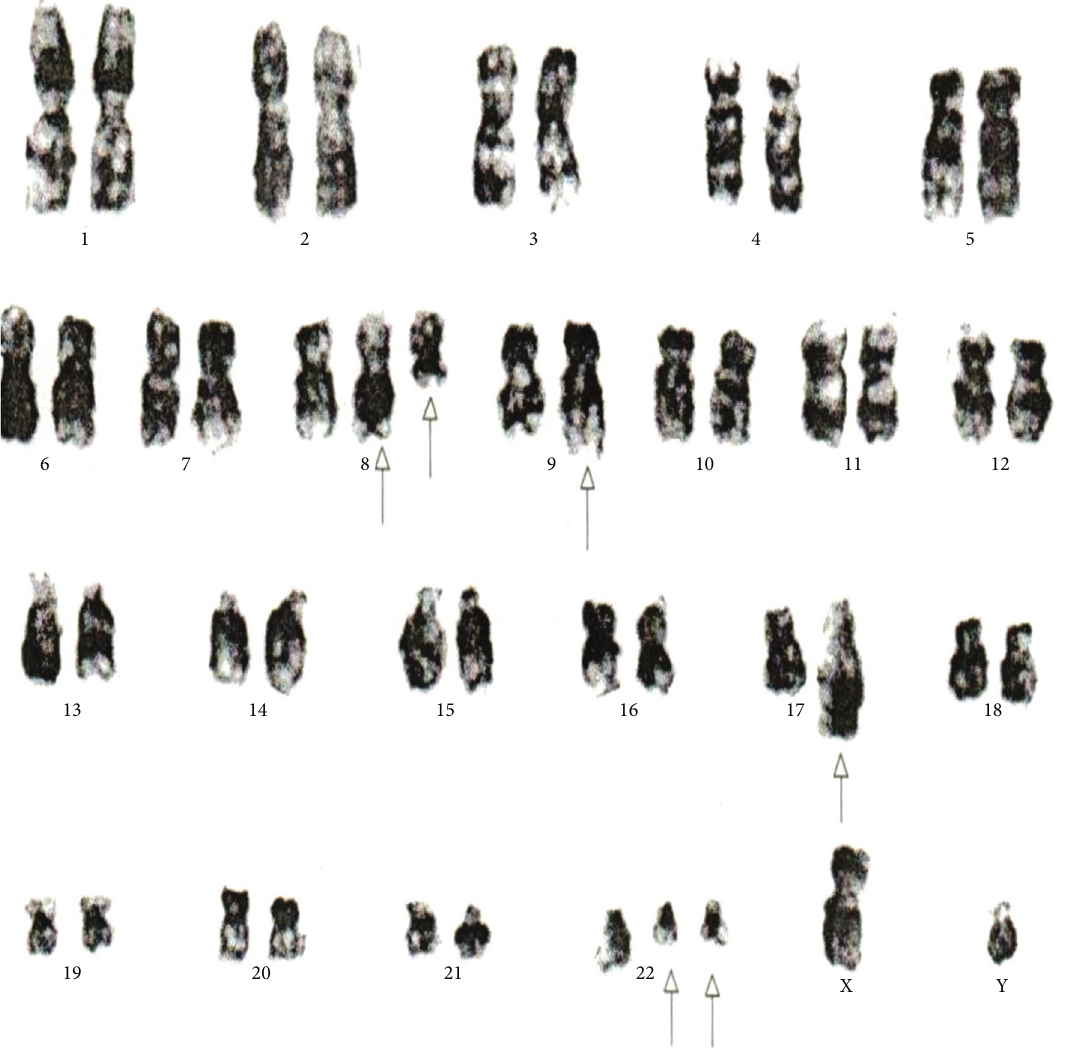
Figure 5: Cytogenetic analysis shows four-way complex/variant translocation, with two additional chromosomes 48XY,+8(8;17),(9;22),+der(22)(q11.2;q23)(q34;q11.2)